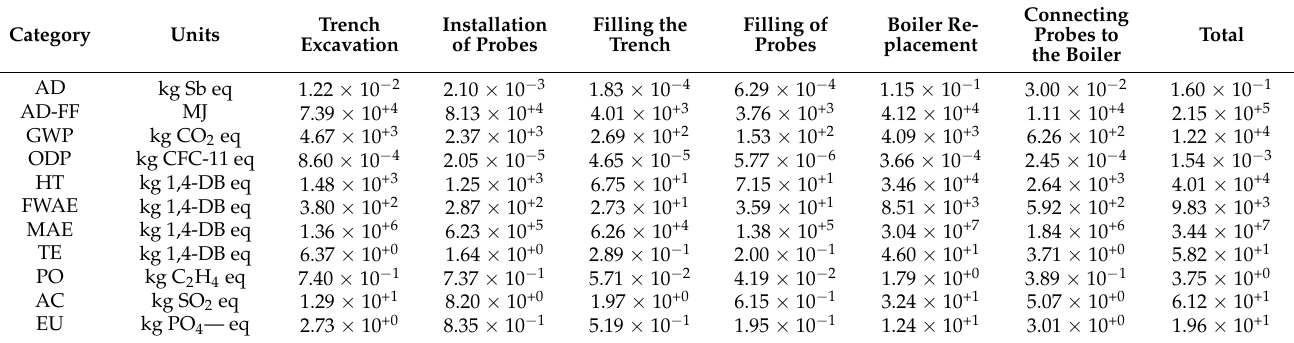
Table 4. Environmental impact by phases for alternative A.